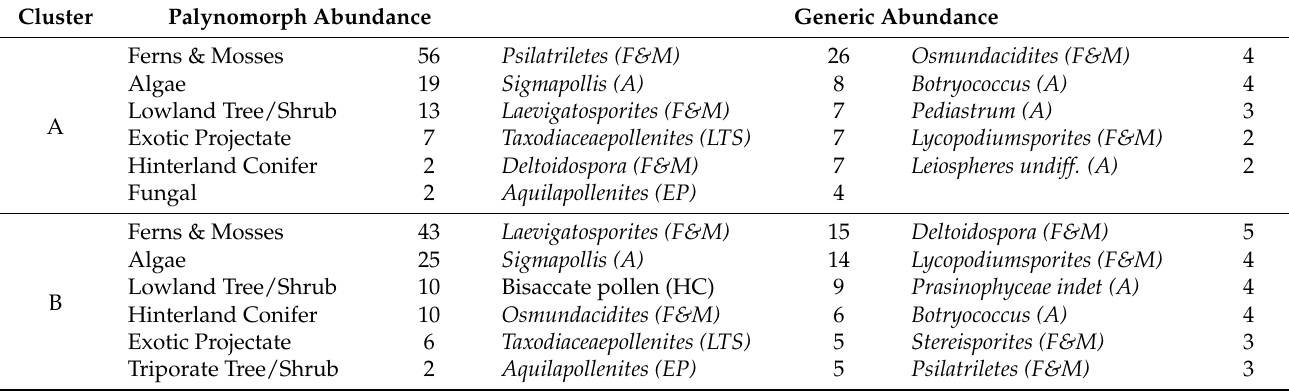
Figure 4. Dendrogram of samples from cluster analysis. Interpreted clusters are labeled A through E. Table 2. Summary of the biotic composition of palynofacies from cluster analysis. Abundance of ecological groups shown for groups with 2% or greater abundance. Generic abundances displayed for taxa comprising 75% of total fossil counts in each cluster.